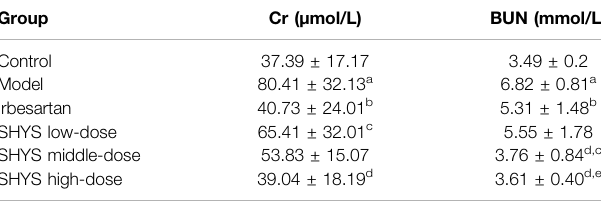
TABLE 1 | Changes of serum Cr and BUN levels in DN rats after SHYS treatment.